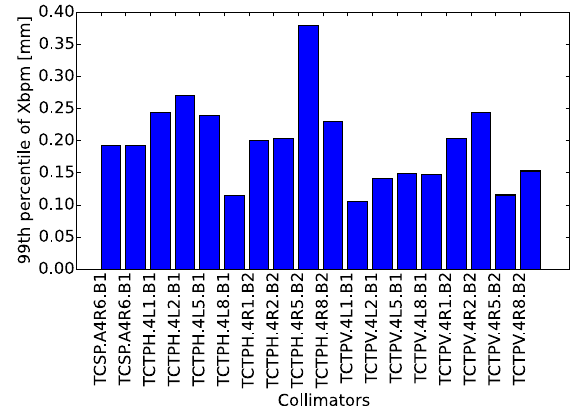
FIG. 18. Distribution of the 99% of the all orbit drifts at each of the BPM collimators in stable beams.